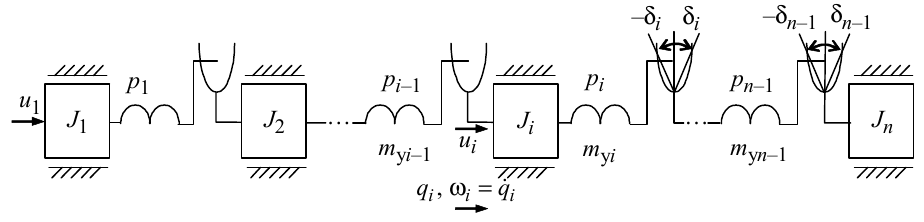
Figure 1. Drive system with elastic couplings and slits.